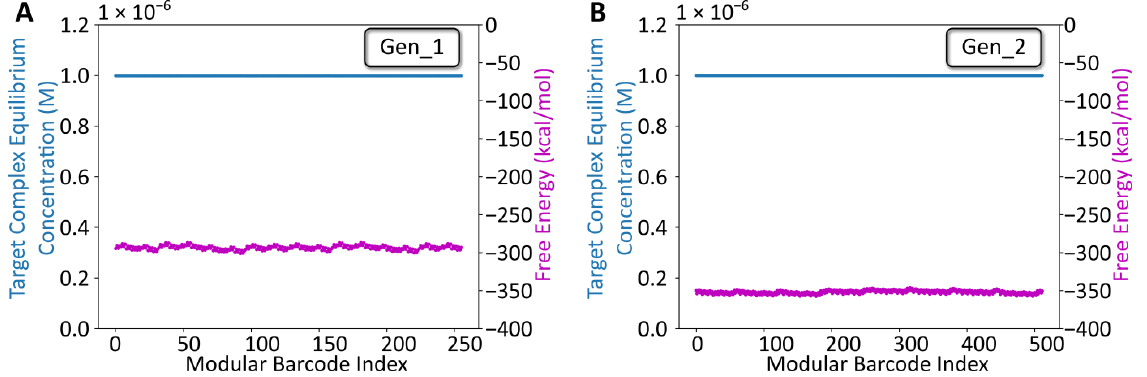
Figure 2. NUPACK Design Analysis. ( A ) Tube analysis results for the gen_1 library. The x-axis is the modular barcode index, a value assigned to each unique sequence within the library. The left y-axis corresponds to the target complex equilibrium concentration predicted using NUPACK after defining a tube containing the eight oligos at a starting concentration of 1 µM, at room temperature for each barcode. The right y-axis corresponds to the free energy for each barcode complex predicted using NUPACK. ( B ) Comparable Tube analysis results for the gen_2 library.